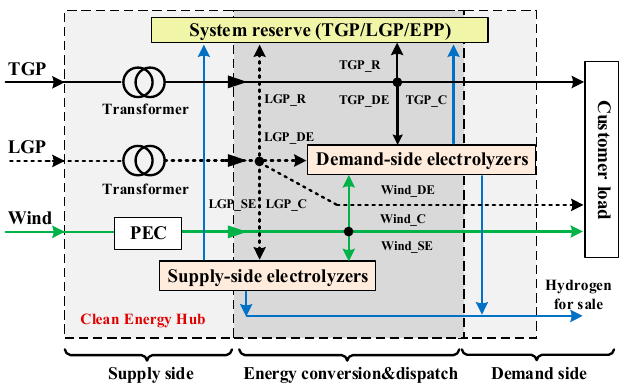
Figure 4. The structure of a clean energy hub (CEH) with low-carbon generation plants (LGPs), traditional generation plants (TGPs), wind farms and electrolyzers.